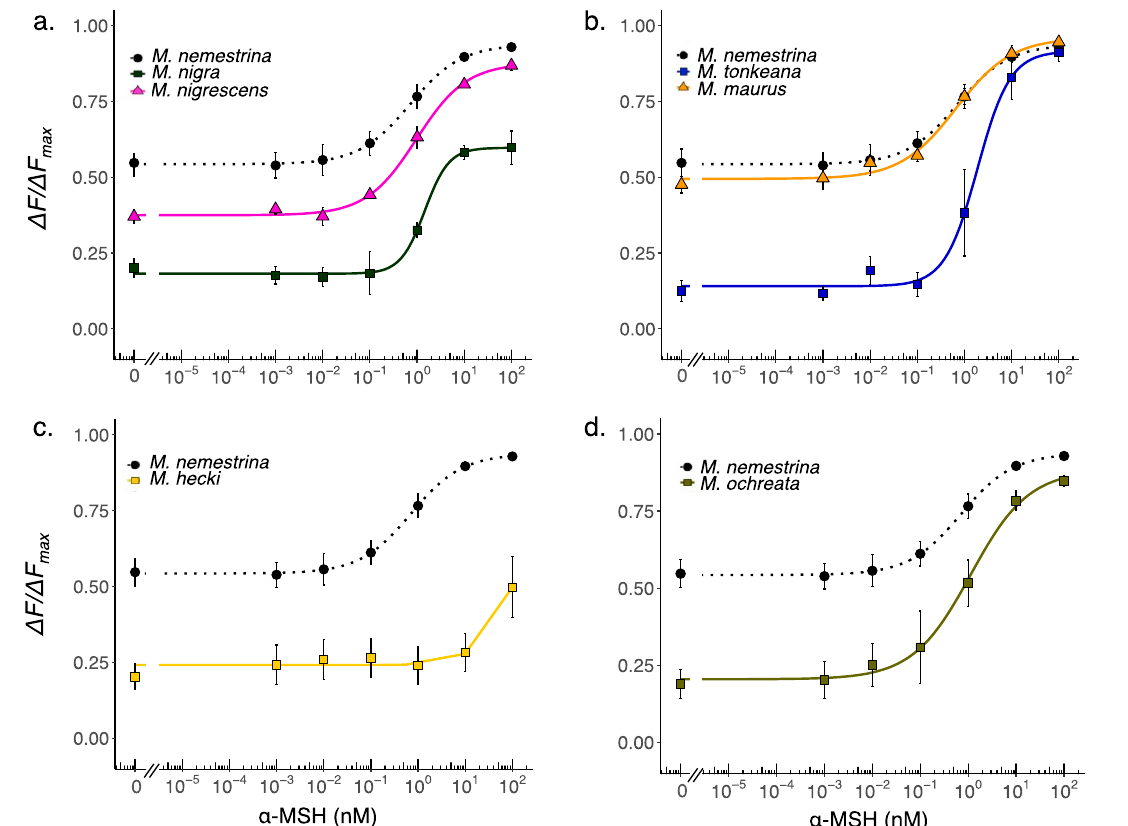
Figure 5. Dose–response curve for MC1R of Sulawesi macaques and M. nemestrina . The response of ( a ) M. nemestrina, M. nigra and M. nigrescens) , ( b ) M. tonkeana and M. maurus, ( c ) M. hecki , ( d ) M. ochreata . Each point represents the mean ± standard error of the mean (SEM) determined from at least three independent